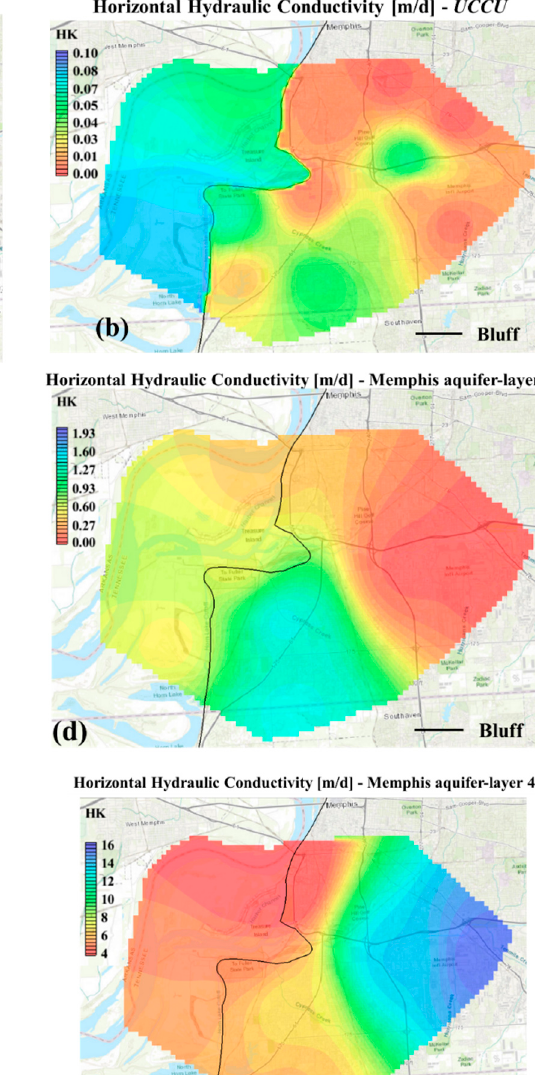
Figure A2. ( a – f ) The vertical hydraulic conductivities of each numerical layer.